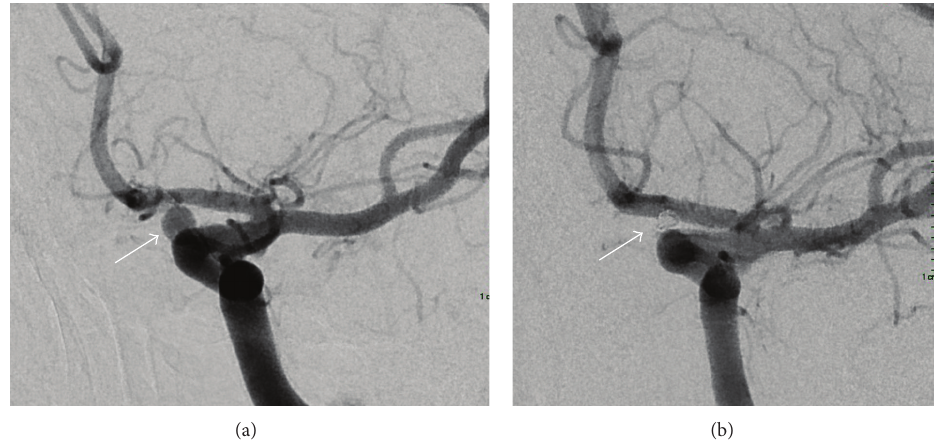
Figure 1: (a) Preoperative and (b) postoperative embolization images of the carotid ophthalmic aneurysm.